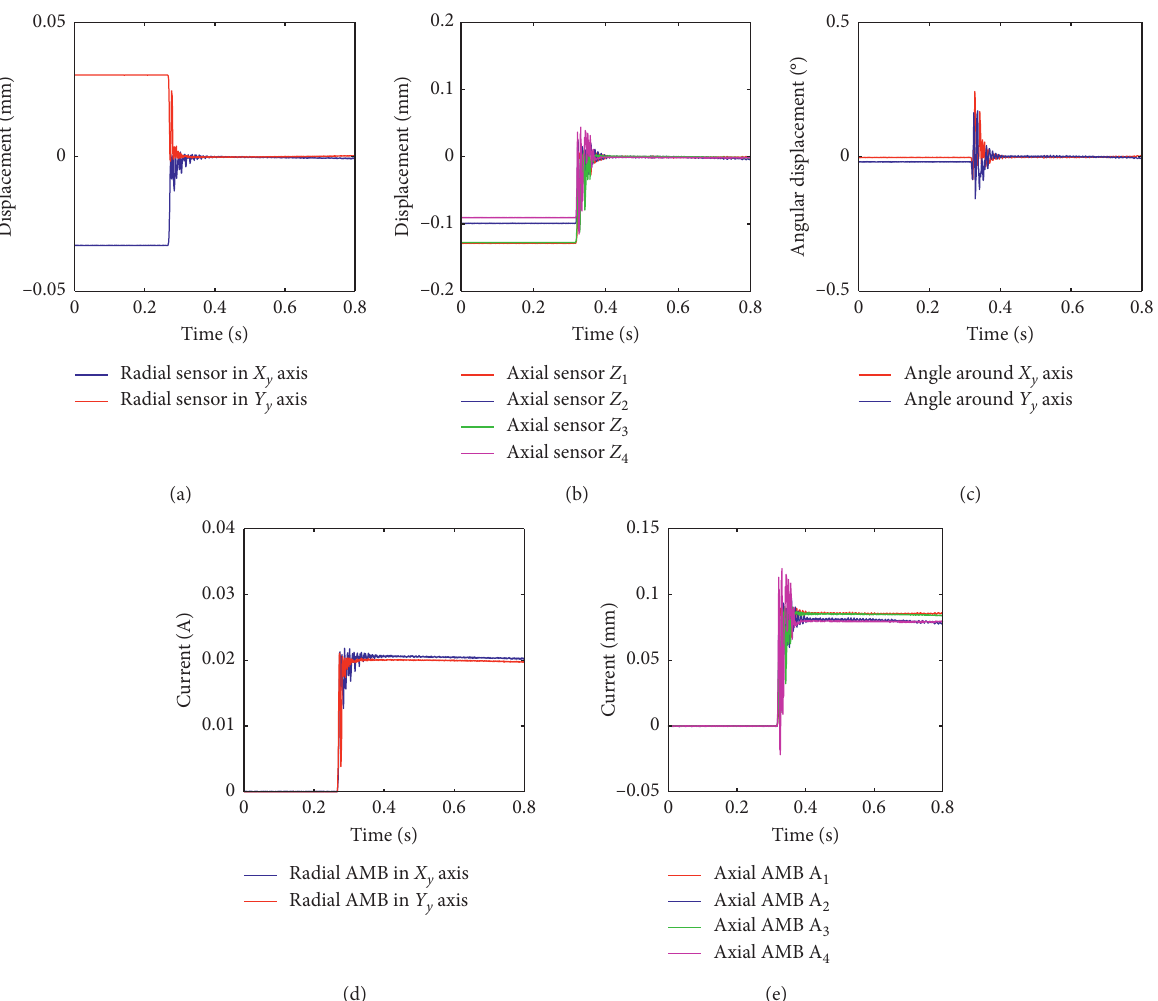
Figure 13: Suspension traces and control currents of yaw gimbal with AMB system. (a) Radial suspension traces. (b) Axial suspension traces. (c) Angular displacement around radial axes. (d) Control currents of radial AMB. (e) Control currents of axial